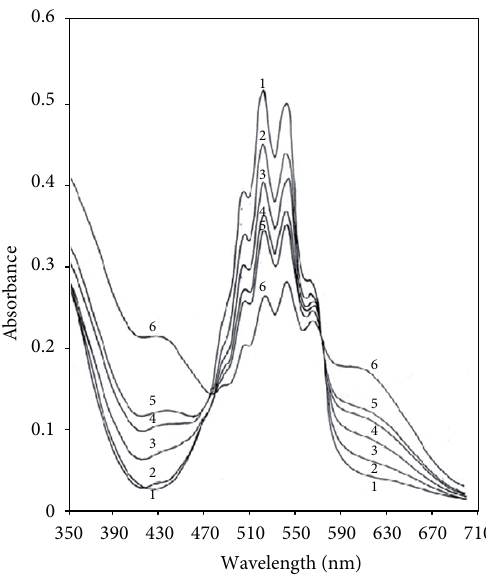
[MnO ] 4 . 1: mixture immediately aer